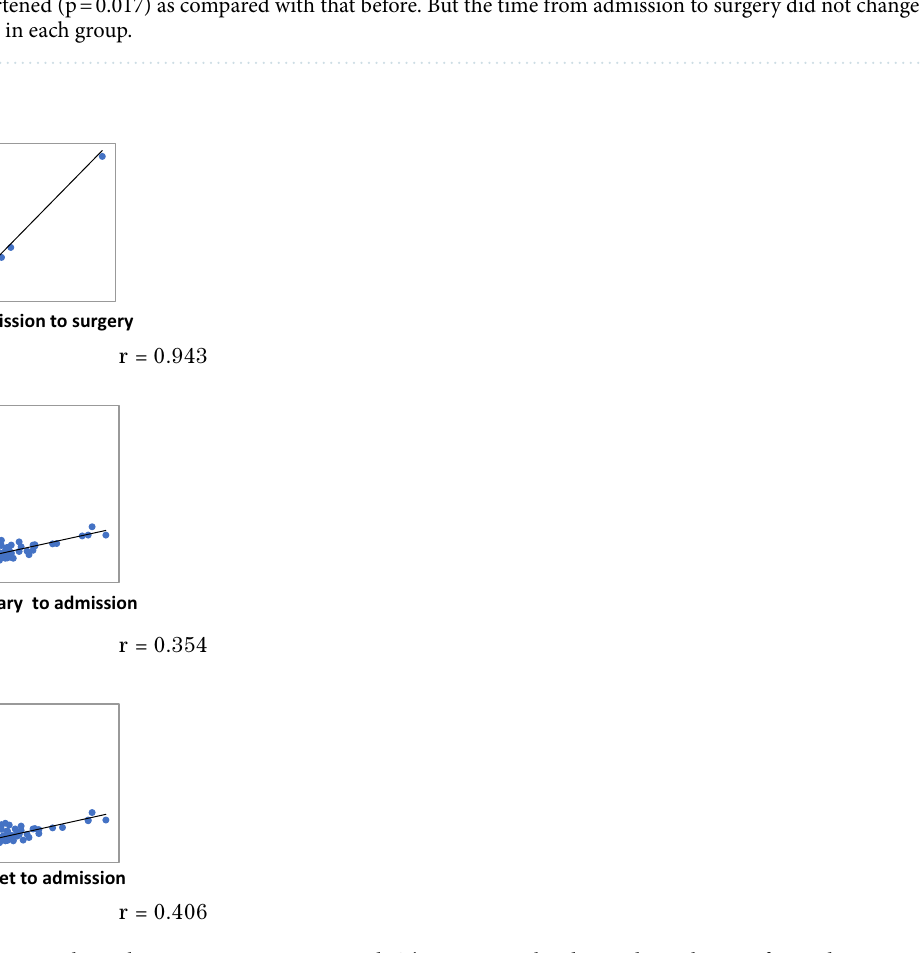
Figure 1. Correlation between preoperative periods. The most correlated period was the time from admission to surgery (r = 0.943), time from onset and primary care to admission had not significantly affected to the duration from onset to surgery.